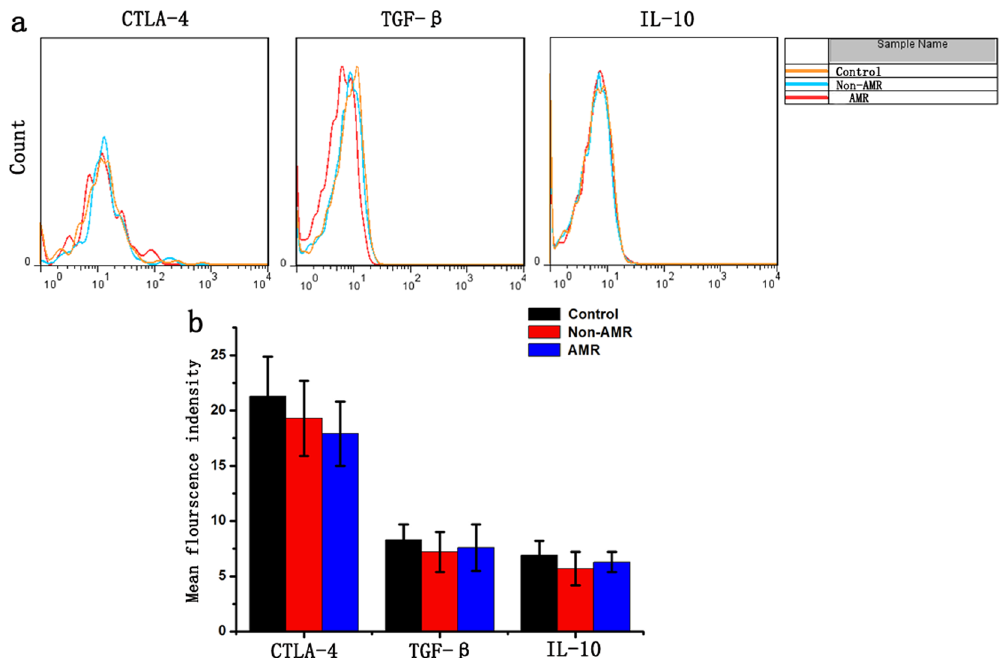
Figure 7. Tfr cells in AMR patients exerted normal inhibitory function. ( a ) Tfr cells were isolated from patients in each group and detected the expression of IL-10, TGF- β and CTLA-4; ( b ) CTLA-4, IL-10 and TGF- β expression of Tfr cells isolated from AMR patients was similar to that from control patients or CRAD patients without